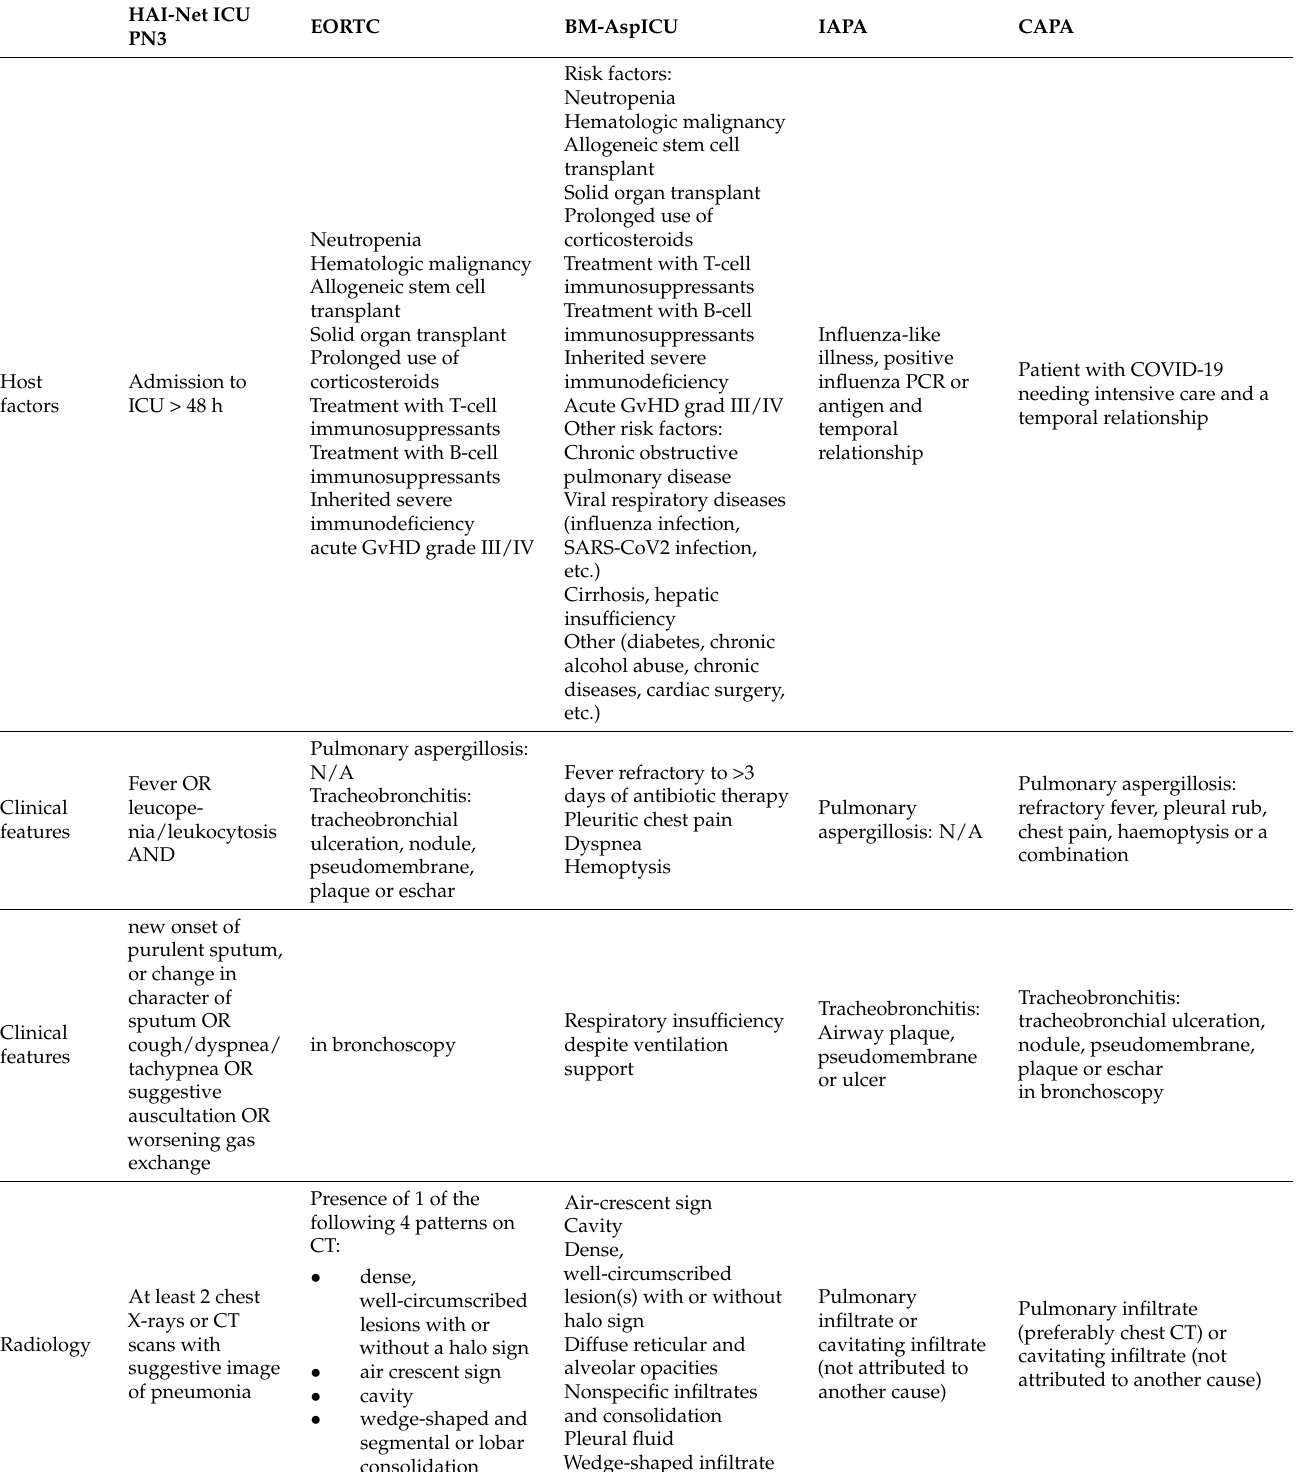
Table 1. Main features of diagnostic